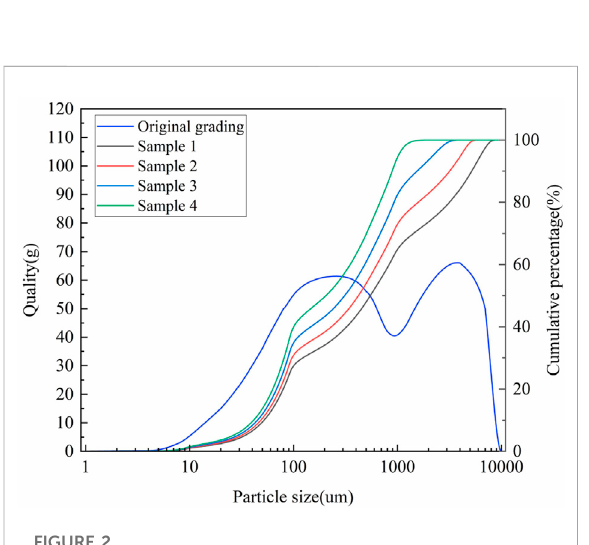
FIGURE 3 X-ray diffraction pattern of coal